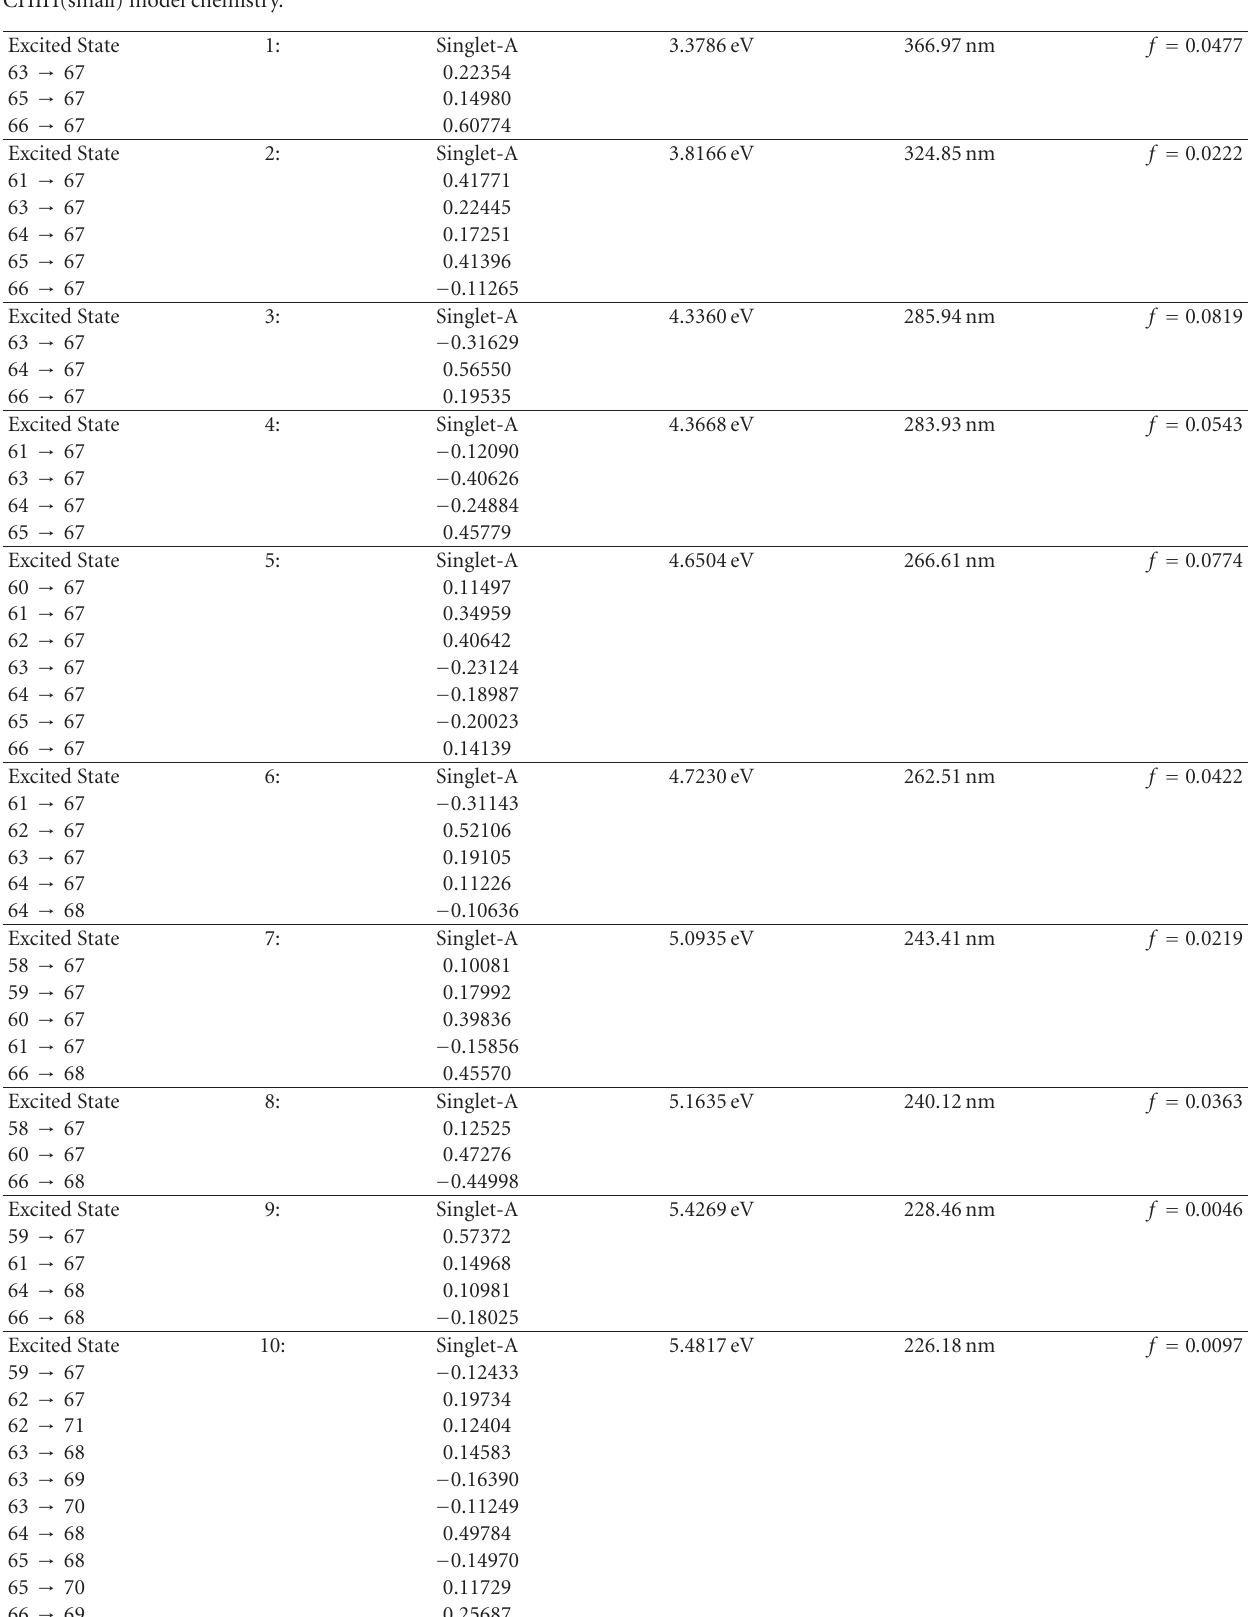
Table 1: Excitation energies and oscillator strengths of 3,4-diphenyl-1,2,5-thiadiazole 1-oxide calculated by using TDDFT and the CHIH(small) model